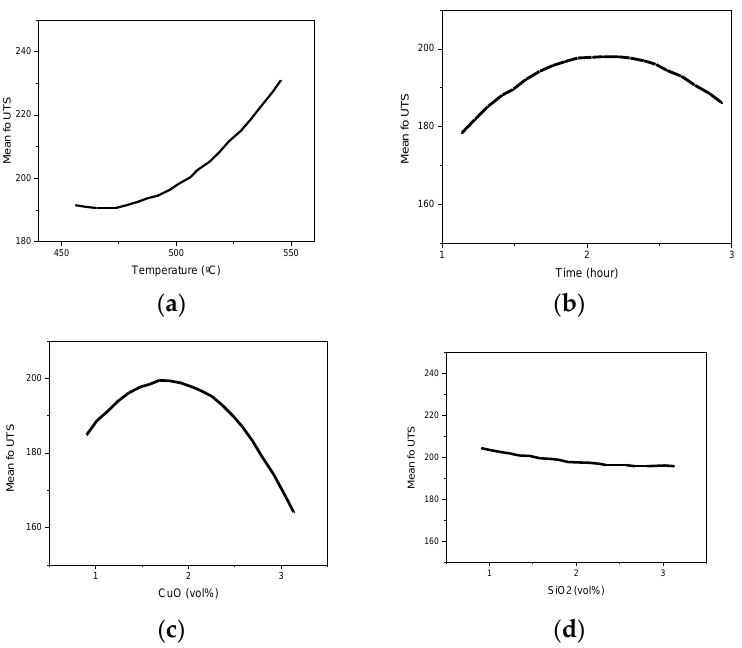
Figure 6. Main effects plot for UTS. ( a ) Temperature; ( b ) Time; ( c ) Copper oxide volume fraction; and ( d ) Silica oxide volume fraction.